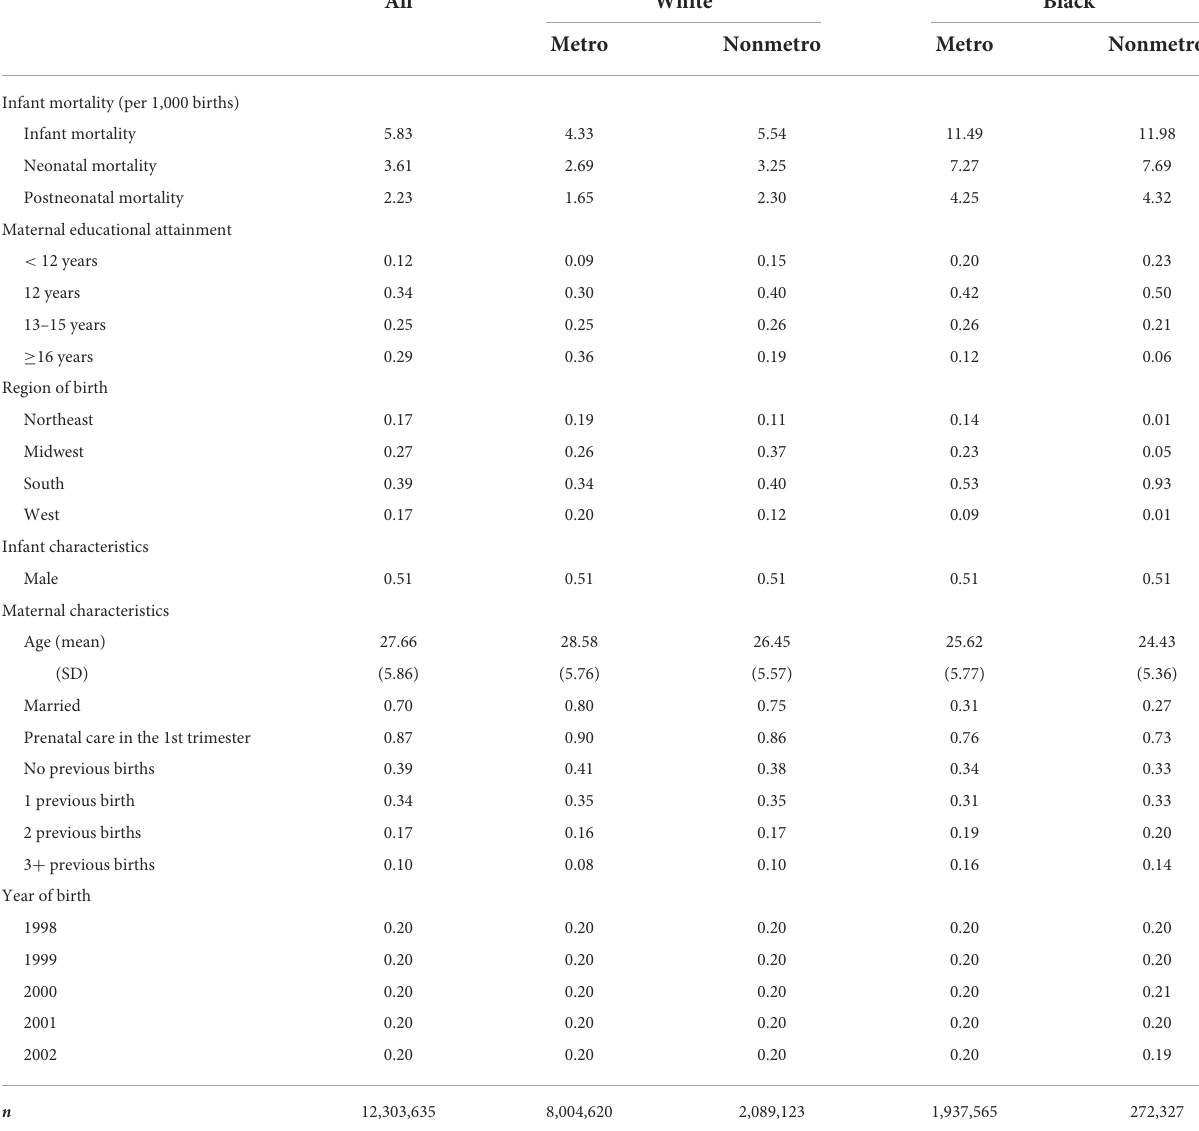
TABLE 2 Summary statistics by race/ethnicity and metropolitan county residence for births between 1998 and 2002. All White Black Metro Nonmetro Metro